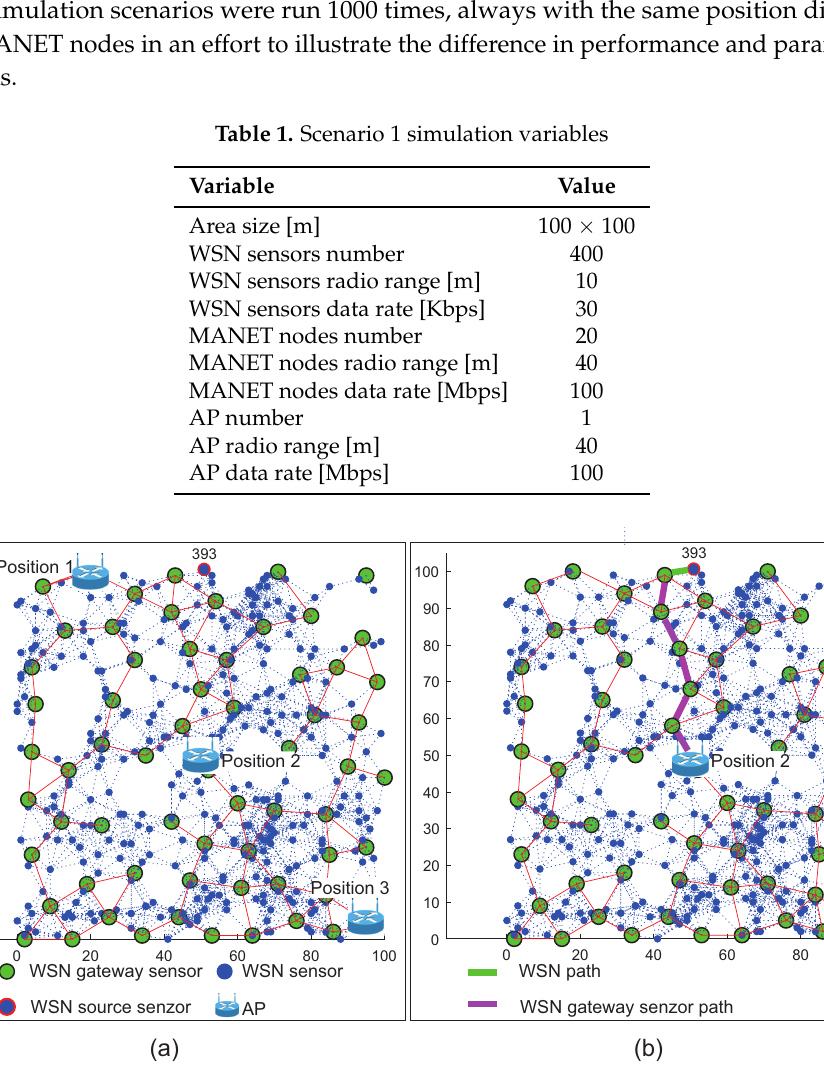
Figure 14. ( a ) Example of simulation scenario 1 with all positions of AP for WSN network. ( b ) Example of optimal routing path from WSNT source sensor to AP deployed in Position 2 (in the middle of the simulation